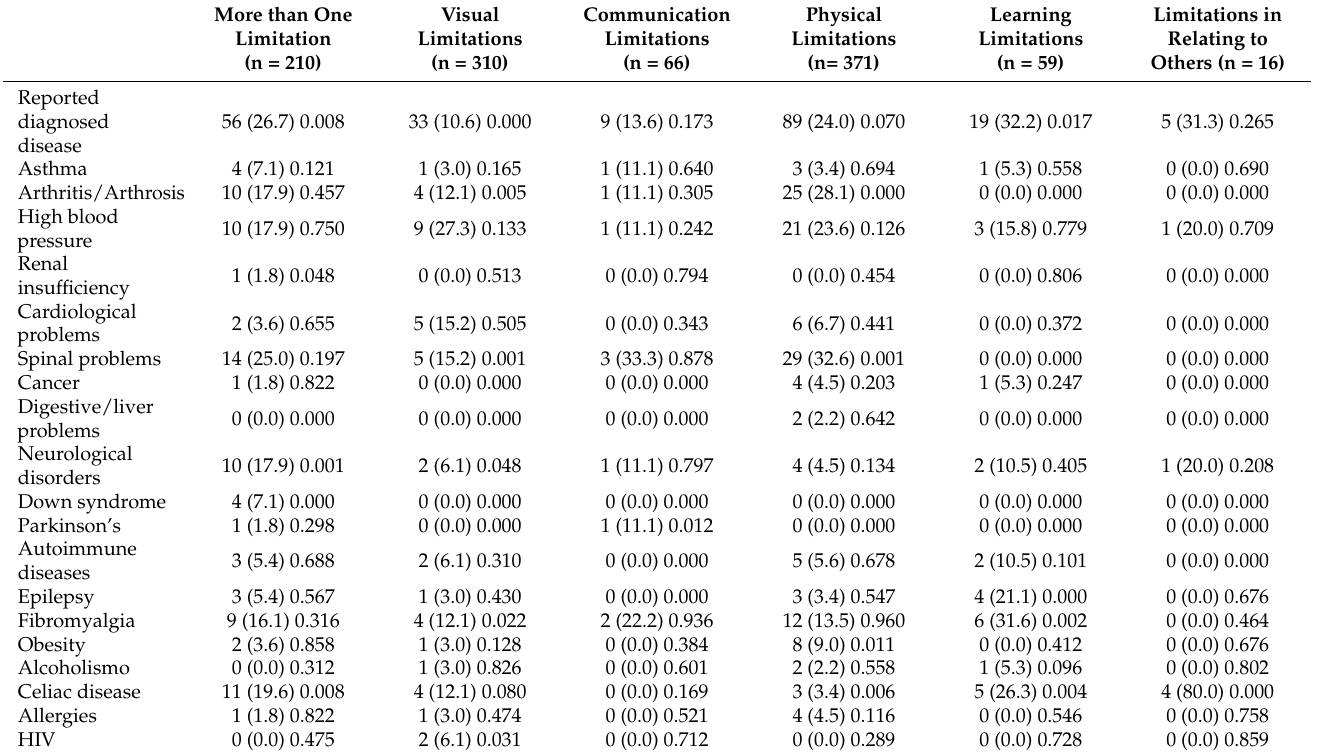
Table 3. Diseases diagnosed according to groups of limitations (n (%) p